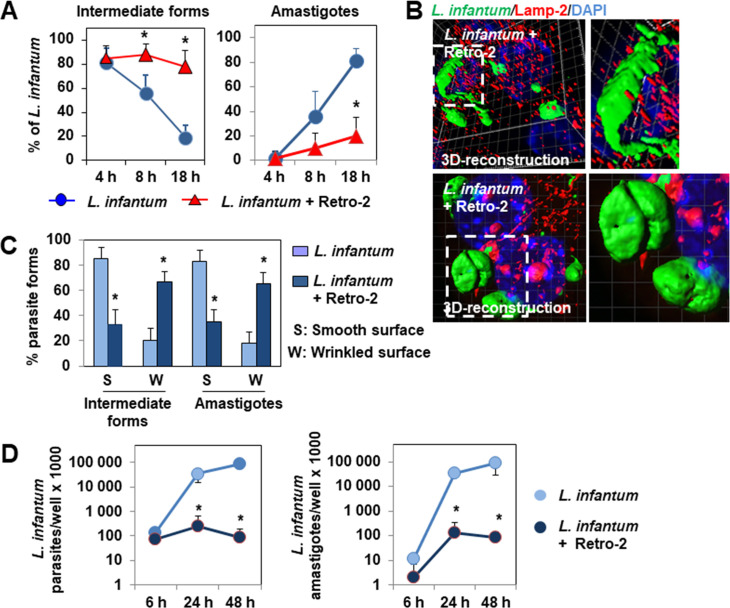
L. infantum LEM 5700 parasites are morphologically altered and die when hosted in Retro-2-treated macrophage-like RAW 264.7 cells.(A) Graph showing the percentage of intermediate parasite forms and amastigotes during an infection time-course in cells infected in the continuous presence, or not, of Retro-2 (1 μM). (B) 3D-reconstruction surface rendering confocal micrographs showing representative altered fusiform-like and ellipsoidal forms of parasites with a wrinkled cell surface, forming deep undulations when hosted in 18 h-Retro-2-treated infected cells. For comparison, see the smooth surface of parasite forms hosted in untreated infected cells in Fig 1. (C) Bar graph showing the percentage of intermediate parasite forms and amastigotes exhibiting a smooth or wrinkled body surface in cells infected for 18 h in the continuous presence, or not, of Retro-2. (D) Graph showing the parasite (left) and amastigote (right) loads determined by RT-qPCR in cells infected in the continuous presence, or not, of Retro-2 during an infection time-course. Confocal micrographs are representative of two independent experiments. The percentage of intermediate parasite forms and amastigotes was determined by analyzing at least 40 cells for each time-point for each condition. The percentage of parasites with a smooth or wrinkled surface was determined by analyzing parasites hosted in at least 30 cells for each time-point for each condition. Parasite and amastigote levels per culture well were quantified by RT-qPCR in two independent experiments in duplicate. Data are presented as averages ± SEM and were analyzed using the unpaired Student t test. *p < 0.01.